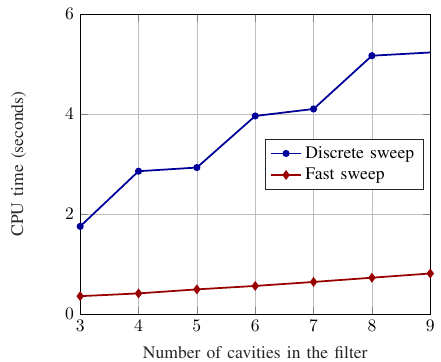
Figure 5. Computation time of discrete and fast frequency sweeps for the all-metallic coupled cavities filter for different filter orders R .